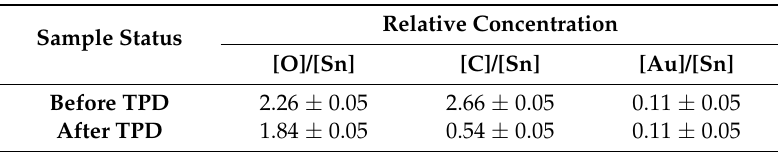
Table 1. The relative atomic ratios of basic elements for VPD SnO 2 nanowires deposited on Au-covered Si (100) substrate.